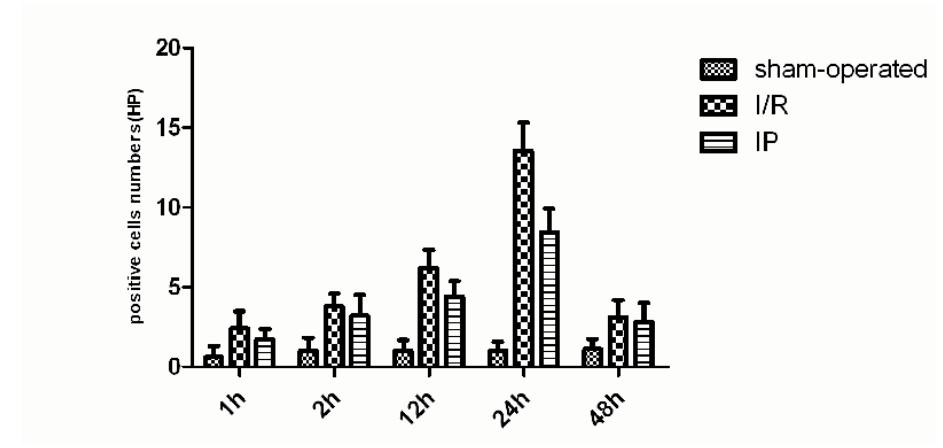
Figure 7 - Effects of ischemic preconditioning on the expression of E-Selectin in rat